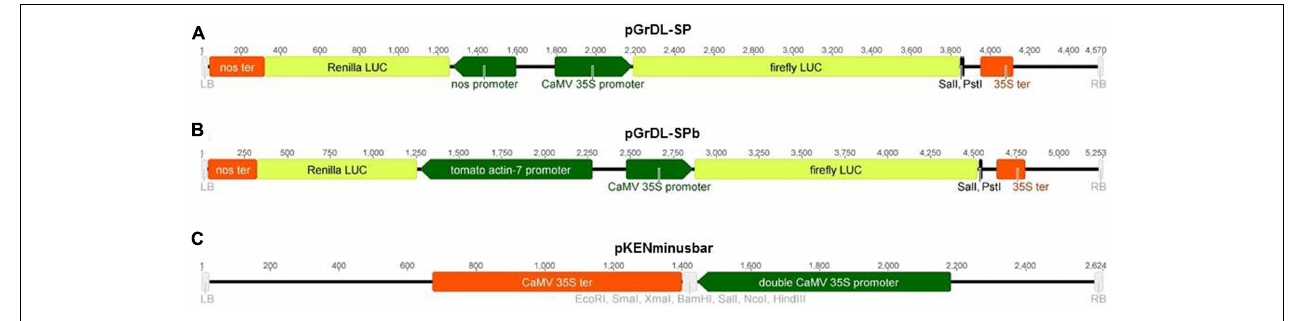
FIGURE 1 | Schematic of the T-DNA regions of constructs used in the study. (A) Dual LUC assay plasmid pGrDL_SP, with Sal I and Pst I restriction sites for target sequence insertion. (B) Dual LUC assay plasmid pGrDL_SPb, with Sal I and Pst I restriction sites for target sequence insertion. (C) Expression plasmid pKENminusbar with multiple cloning sites for miRNA precursor